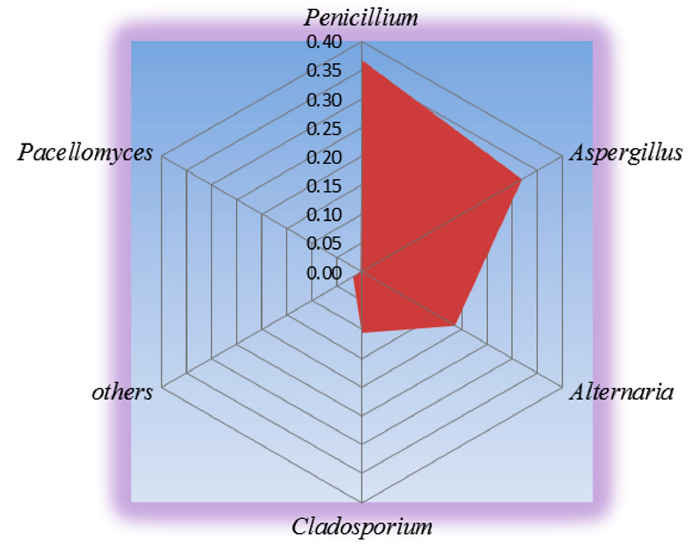
Fig. 3. Total Relative abundance by fungi species from colony forming unit computed in two populations (Hospital & Faculty). Surface area of picture= indoor environment, Red color = Airborne fungi of indoor